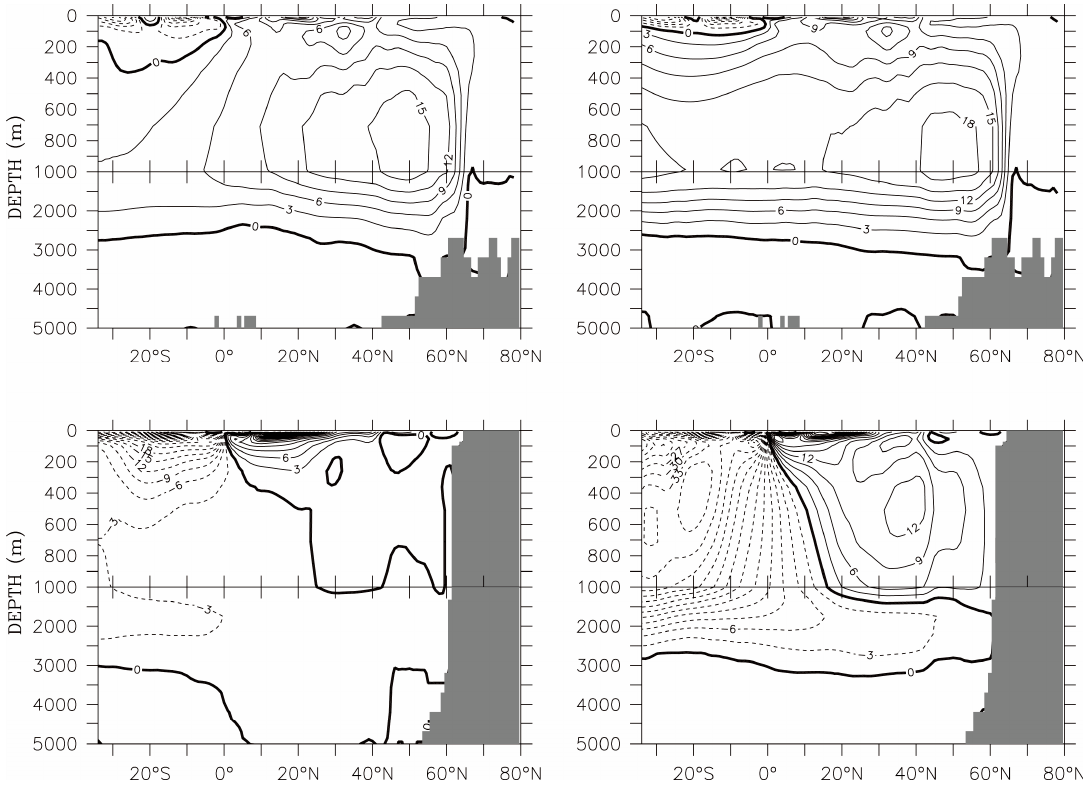
Figure 11. Average streamfunctions (Sv) from Equation (10) in the Atlantic ( upper ) and in the Indo-Pacific ( lower ); OTEC is active in the Atlantic only ( left ), or in the Indo-Pacific only ( right ).